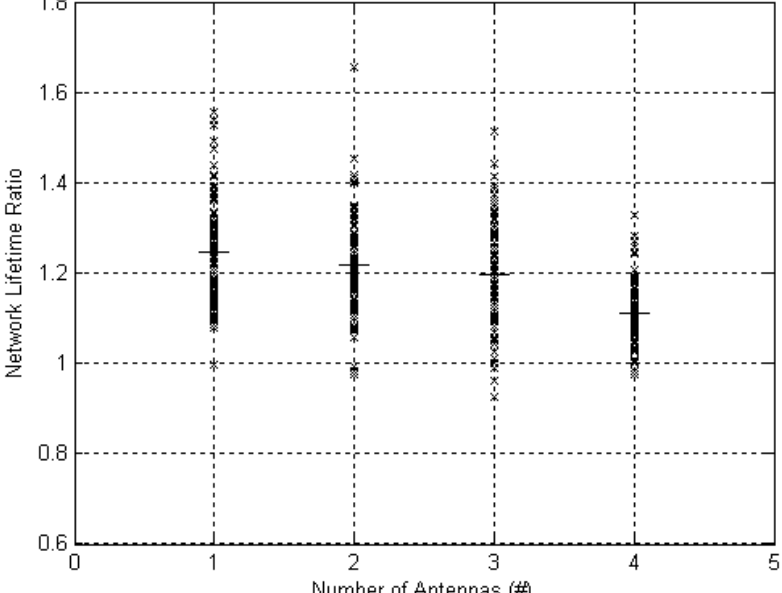
Figure 11. Improvement in Network Lifetime for M = 100 vs. M = 0 and varying number of antennas at the off-body access point. The straight horizontal lines depict the mean